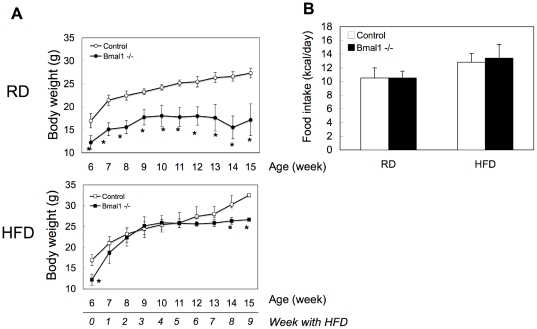
Effects of a high-fat diet feeding on the body weight.(A) Male control mice and Bmal1 -/- mice were subjected to a high-fat diet (HFD) challenge at 6 weeks of age. The body weights of the mice fed either a regular diet (RD) or HFD were determined. Data represent the means ± SEM (n = 8 for each genotype). Asterisks indicate significant differences (P<0.05). (B) The daily average of the calorie intake of male mice at 11 weeks of age (5 weeks with a HFD) was determined. Data represent the means ± SEM (n = 8 for each genotype and treatment).